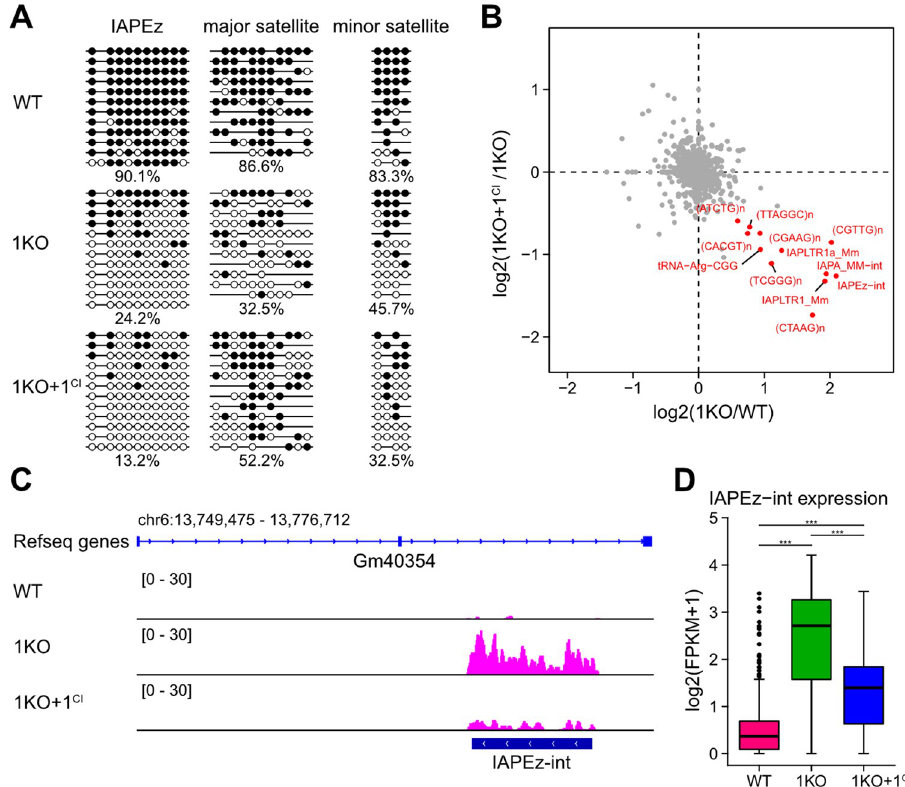
Fig 4. IAPEz-int repression without apparent acquisition of DNA methylation in 1KO+1 CI ESCs. ( A ) DNAme levels of repeat sequences detected by targeted bisulfite sequencing in ESCs. Black and white circles mean methylated and unmethylated CpG, respectively. ( B ) The scatter plot shows the repressive effect of DNMT1 CI on repetitive sequence expression in 1KO ESCs. Red dots, repeat sequence families, which are up-regulated in 1KO ESCs compared to WT ESCs (1KO / WT, log2 FC > 0.5), but down-regulated in 1KO+1 CI ESCs compared to 1KO ESCs (1KO+1 CI / 1KO, log2 FC < − 0.5). ( C ) IAPEz-int expression located at Gm40354. A vertical axis, FPKM; a horizontal axis, corresponding genomic position. ( D ) IAPEz-int expression levels in WT, 1KO, and 1KO+1 CI ESCs ( ��� p < 0.001).